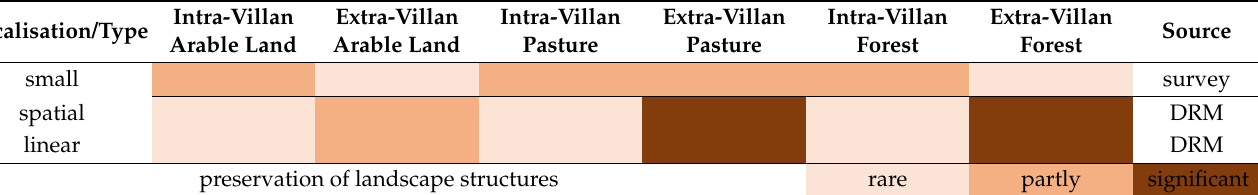
Table 2. Overview of the occurrence of landscape structure types according to current land